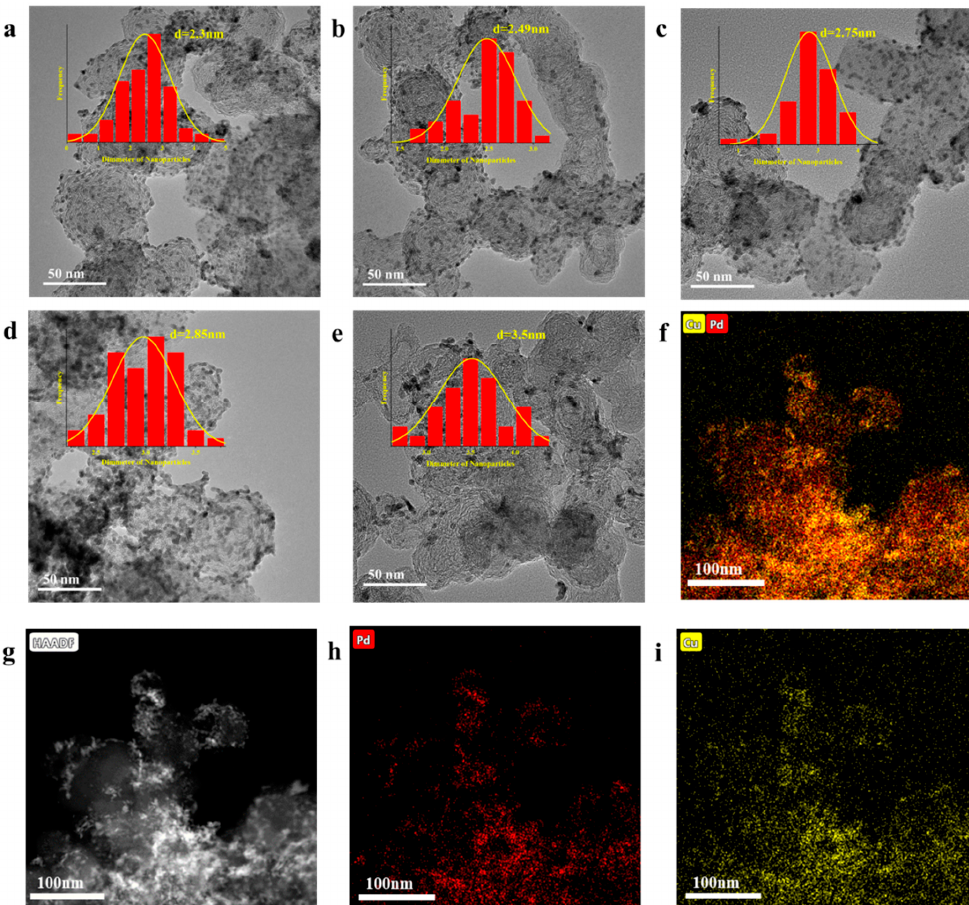
Figure 2. TEM Micrographs of Pd x Cu y /XC-72 ( a ) Pd 1 Cu 4 /XC-72 (2.3 ± 1 nm), ( b ) Pd 2 Cu 3 /XC-72 (2.49 ± 1 nm), ( c ) PdCu/XC-72 (2.75 ± 1 nm), ( d ) Pd 3 Cu 2 /XC-72 (2.85 ± 2 nm), and ( e ) Pd 4 Cu 1 /XC-72 (3.5 ± 1 nm). ( f – i ) EDX element maps of Pd 3 Cu 2 /XC-72.